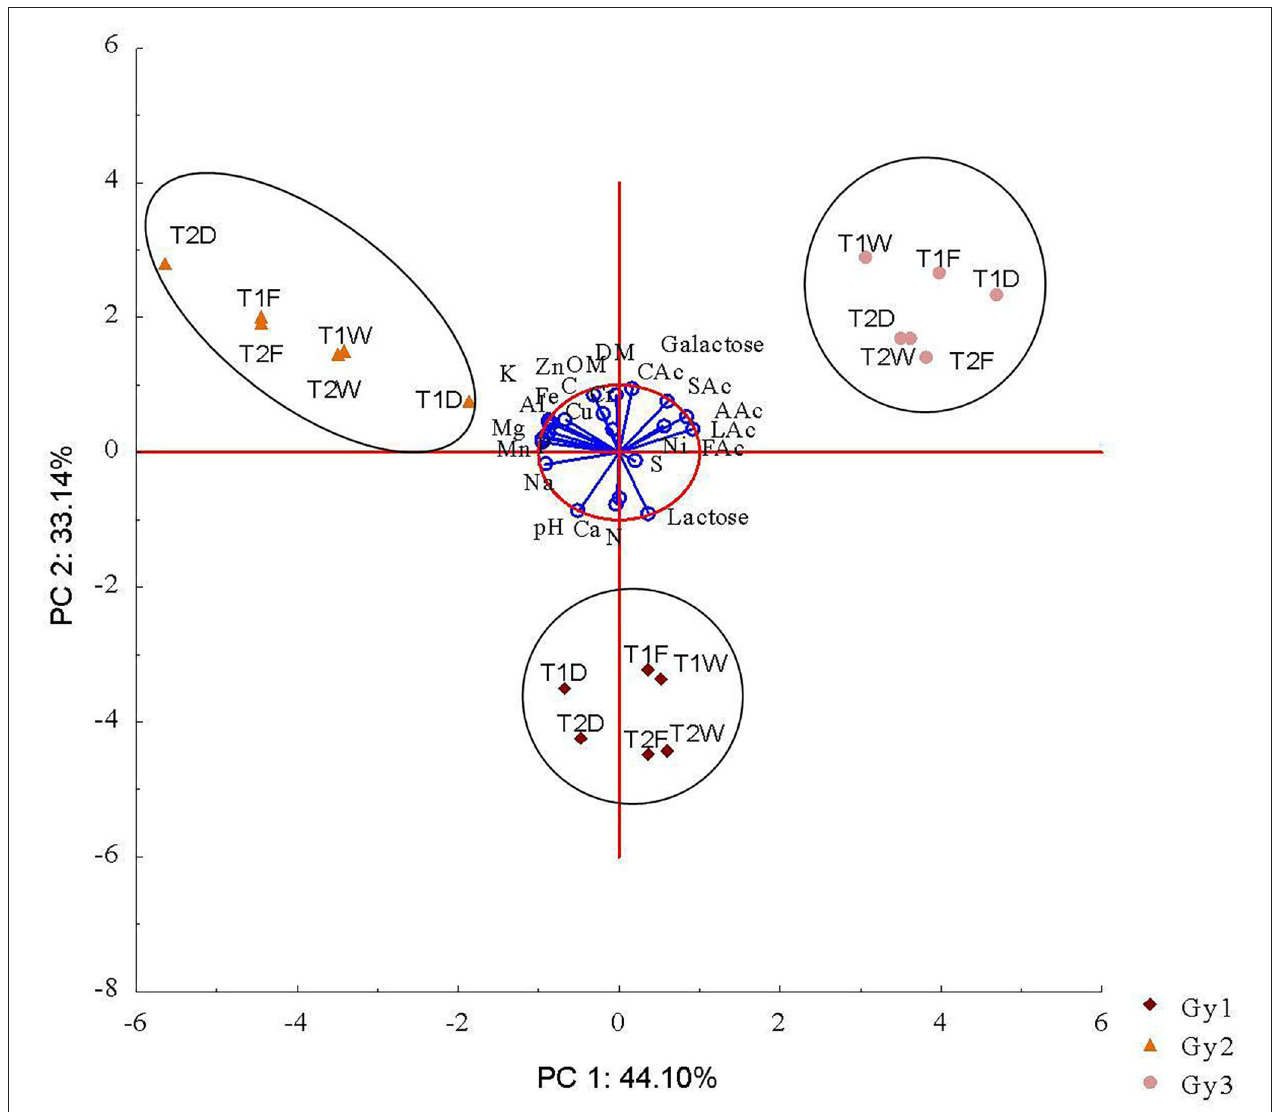
FIGURE 2 | Principal component analysis for differences between batches, form and time of sampling based on all parameters investigated. D, Dried; F, Freeze-dried; W, Wet; Time, T1, T2. LAc, Lactic Acid; CAc, Citric Acid; SAc, Succinic Acid; FAC, Formic Acid; AAc, Acetic